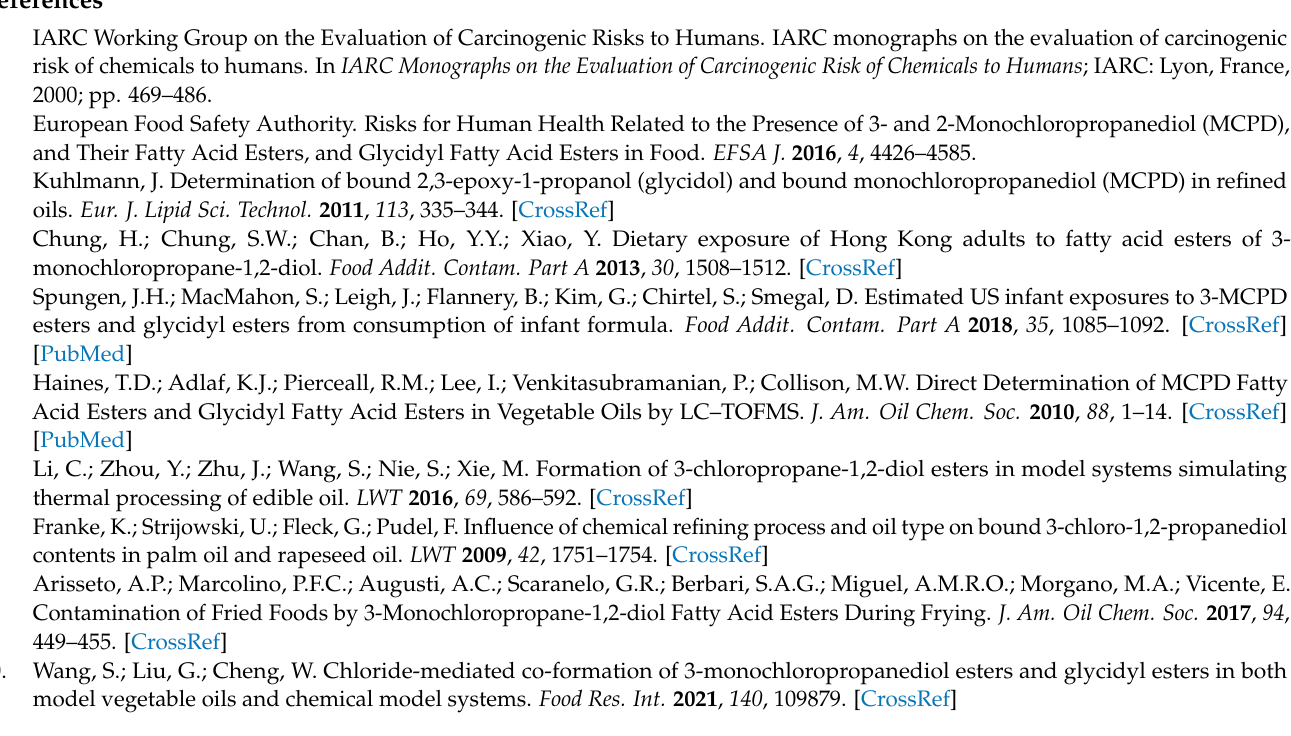
Table S2: Calibration curves, correlation coefficients ( r ), LODs and LOQs for GEs and 3-MCPDE, Table S3: Recovery and repeatability results of GEs and 3-MCPDE